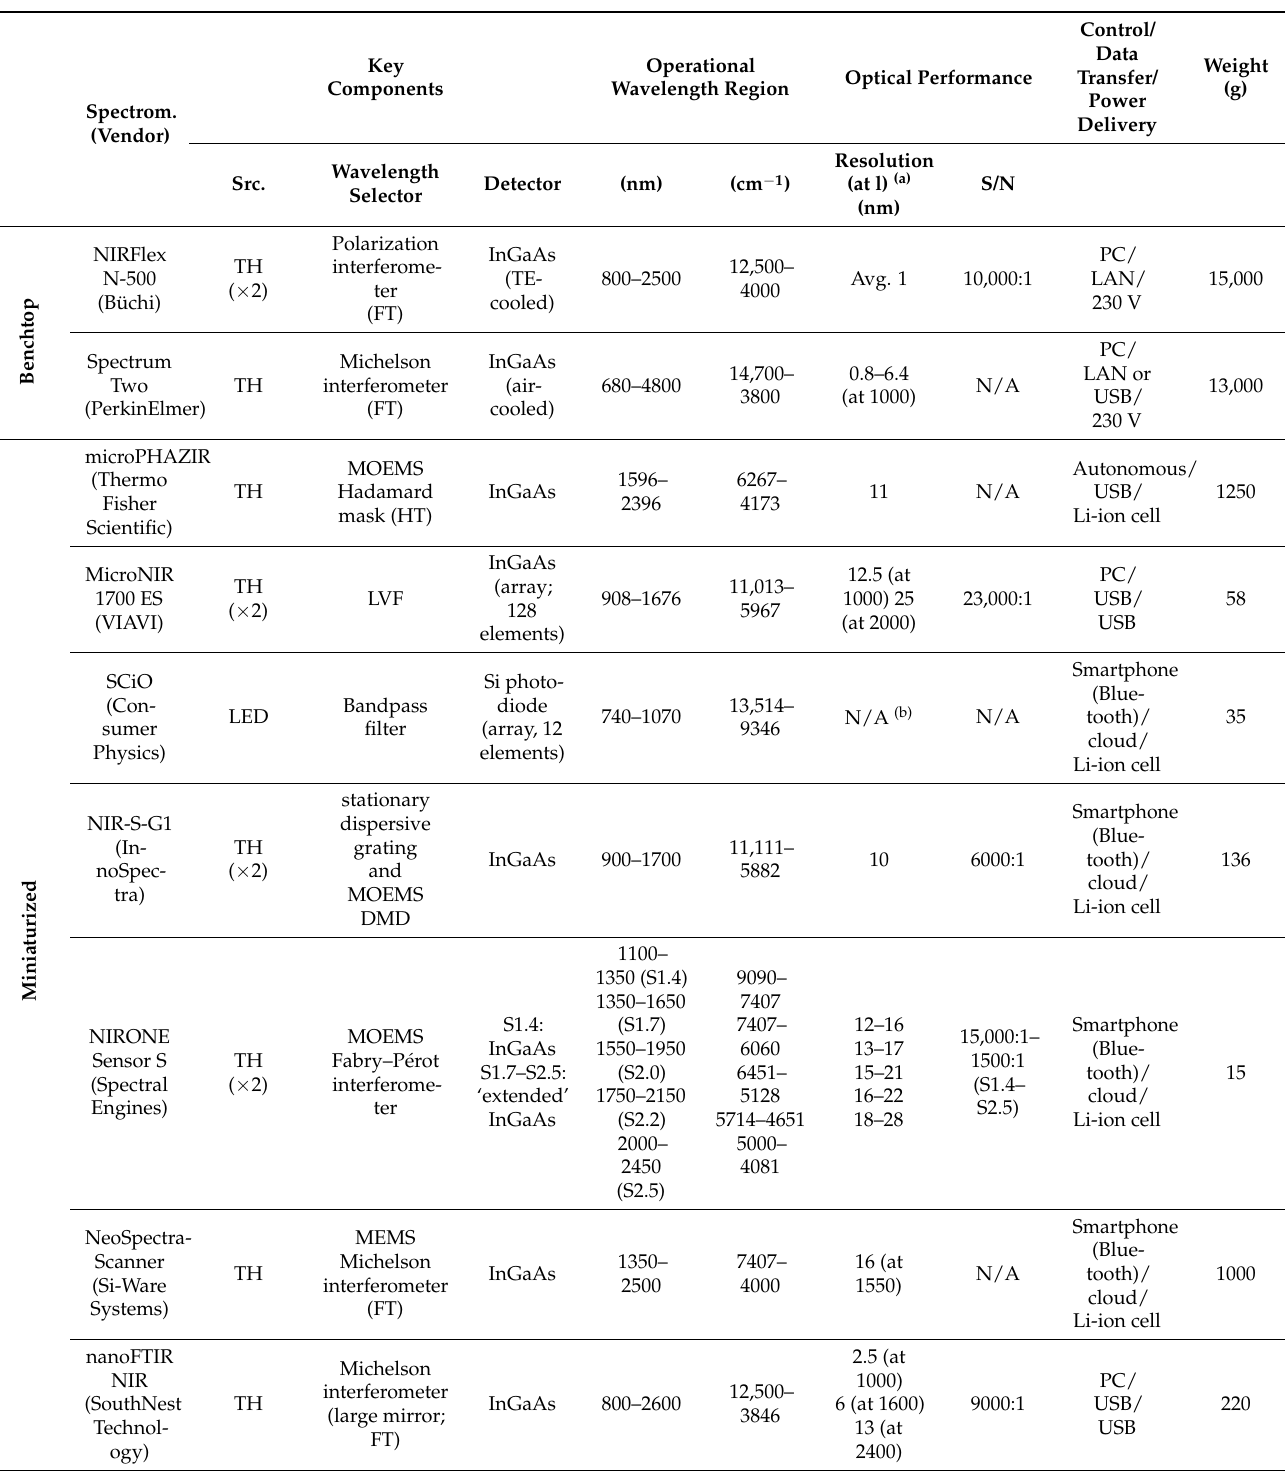
Table 1. The operational characteristics of selected miniaturized NIR spectrometers available on the market in comparison with two exemplary benchtop FT-NIR